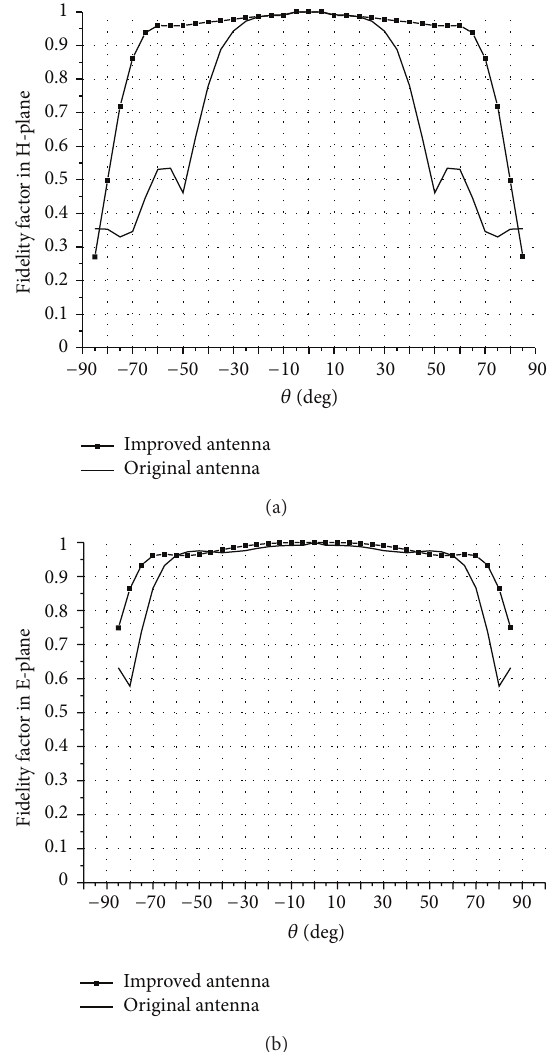
Figure 7: (a) Simulation results of fidelity factor in H-plane ( 𝜑 = 90 ∘ ) and (b) simulation results of fidelity factor in E-plane ( 𝜑 = 0 ∘ ).